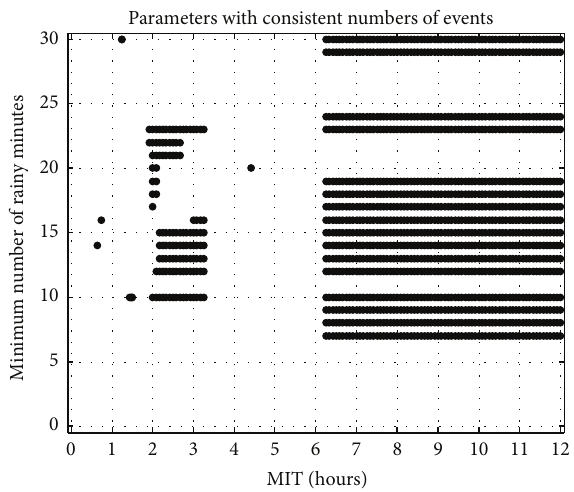
Figure 10: A plot of points in the MIT and L parameter space where all ten tipping-bucket detectors register the same number of observed events over the approximately 2-month long interval of investigation. Marks indicate plausible